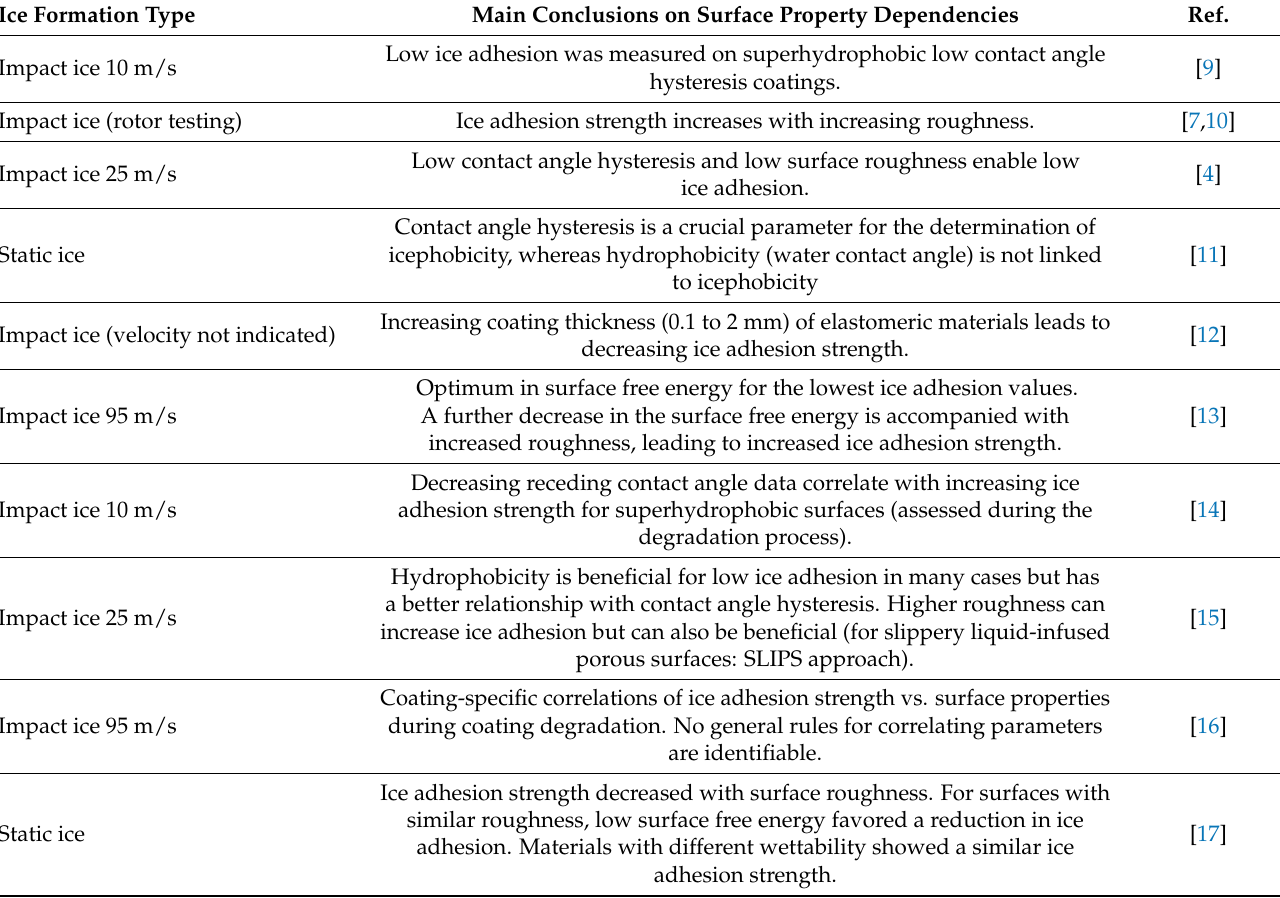
Table 1. Summary of studies on the surface properties and their influence on ice adhesion strength, assessed in centrifuge test